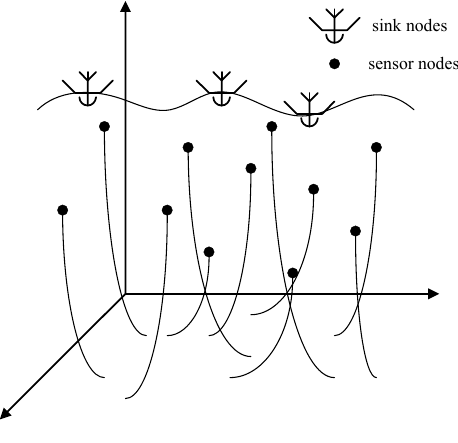
Figure 1. An Underwater Wireless Sensor Network (UWSN) with passive